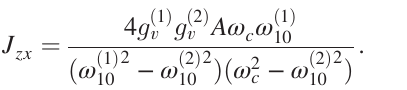
FIG. 10. Coefficient K of the contributions to J 1 Þ 2 Þ Þ [divided by the two coupling constants ω − ω like ω ð 10 Þ ð m = ð c 1 Þ ð 2 Þ and the driving intensity g ð ec g ec A ] as a function of line is the numerical result, and the dashed line is the analytical one, Eq. (43). The other parameters are g ð 1 Þ ¼ g ð 2 Þ ¼ 1 . 264 ℏ ω ð 1 Þ ð 2 Þ ¼ 10 . 5 ℏ ω ð 1 Þ t ð 1 Þ ¼ 10 ℏ ω ð m , and t m